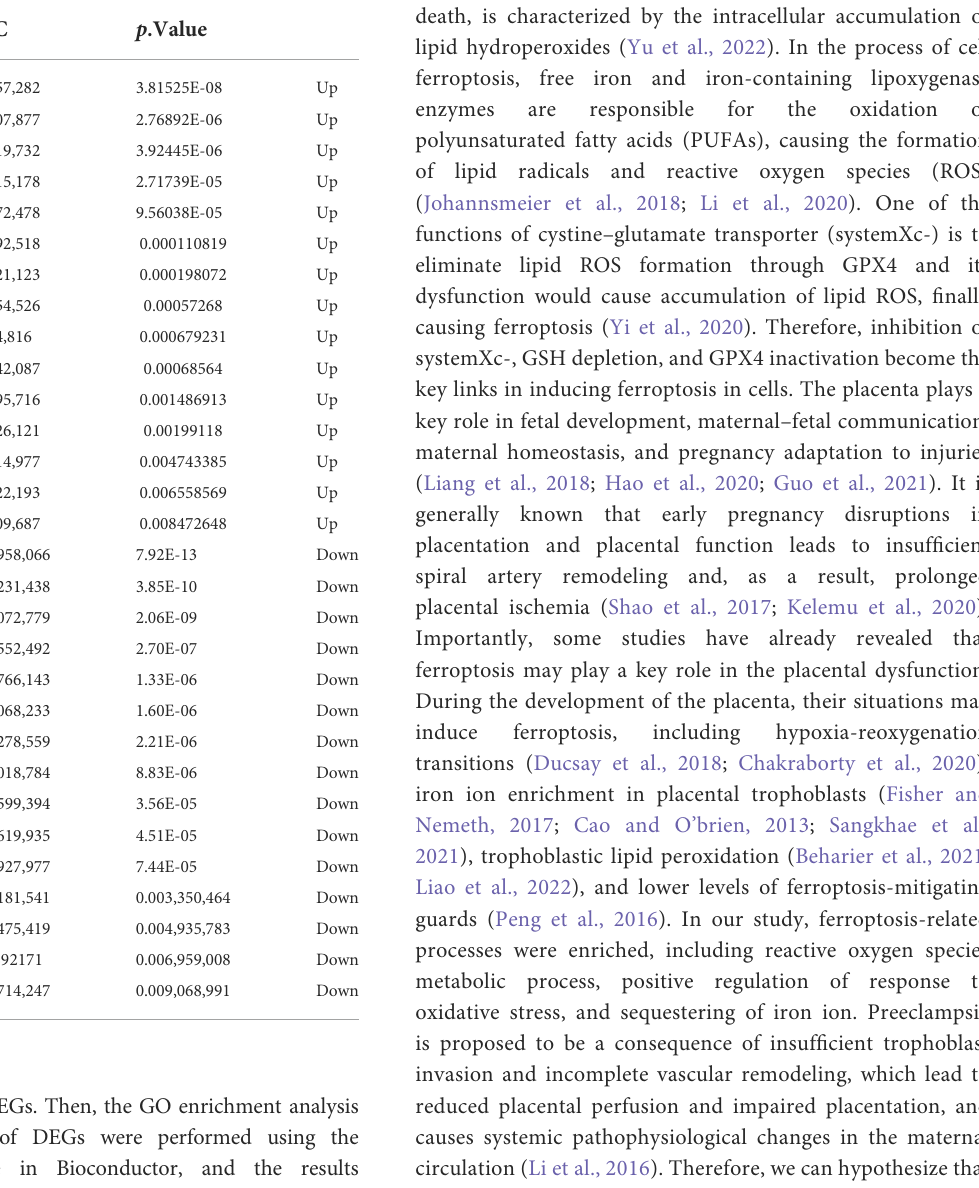
TABLE 3 Ferroptosis differentially expressed genes of